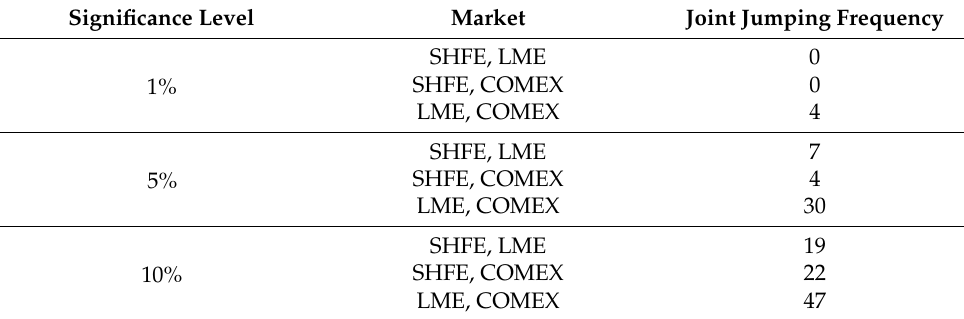
Table 16. A number of linkage jumps between two markets.